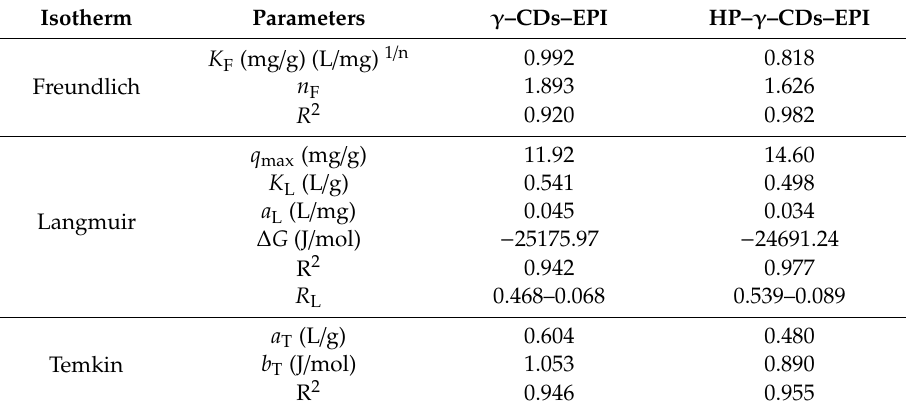
Figure 9. Freundlich, Langmuir and Temkin isotherms ( γ –CDs–EPI ( • ), HP– γ –CDs–EPI ( ○ )). Table 3. Adsorption isotherm constants.